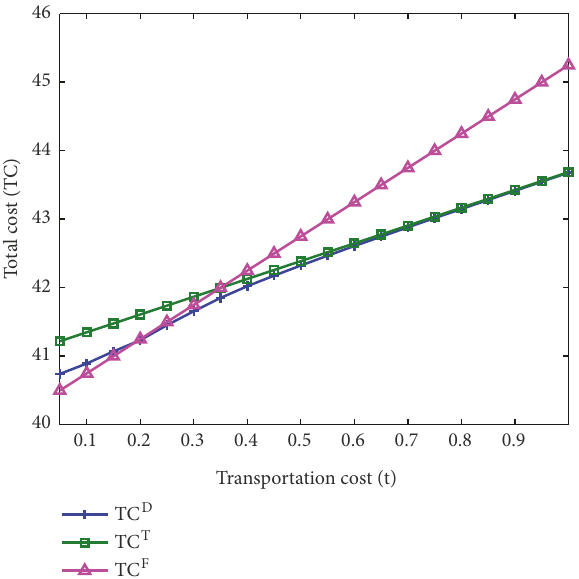
Figure 3: Impact of 𝑡 on the total costs of these systems.